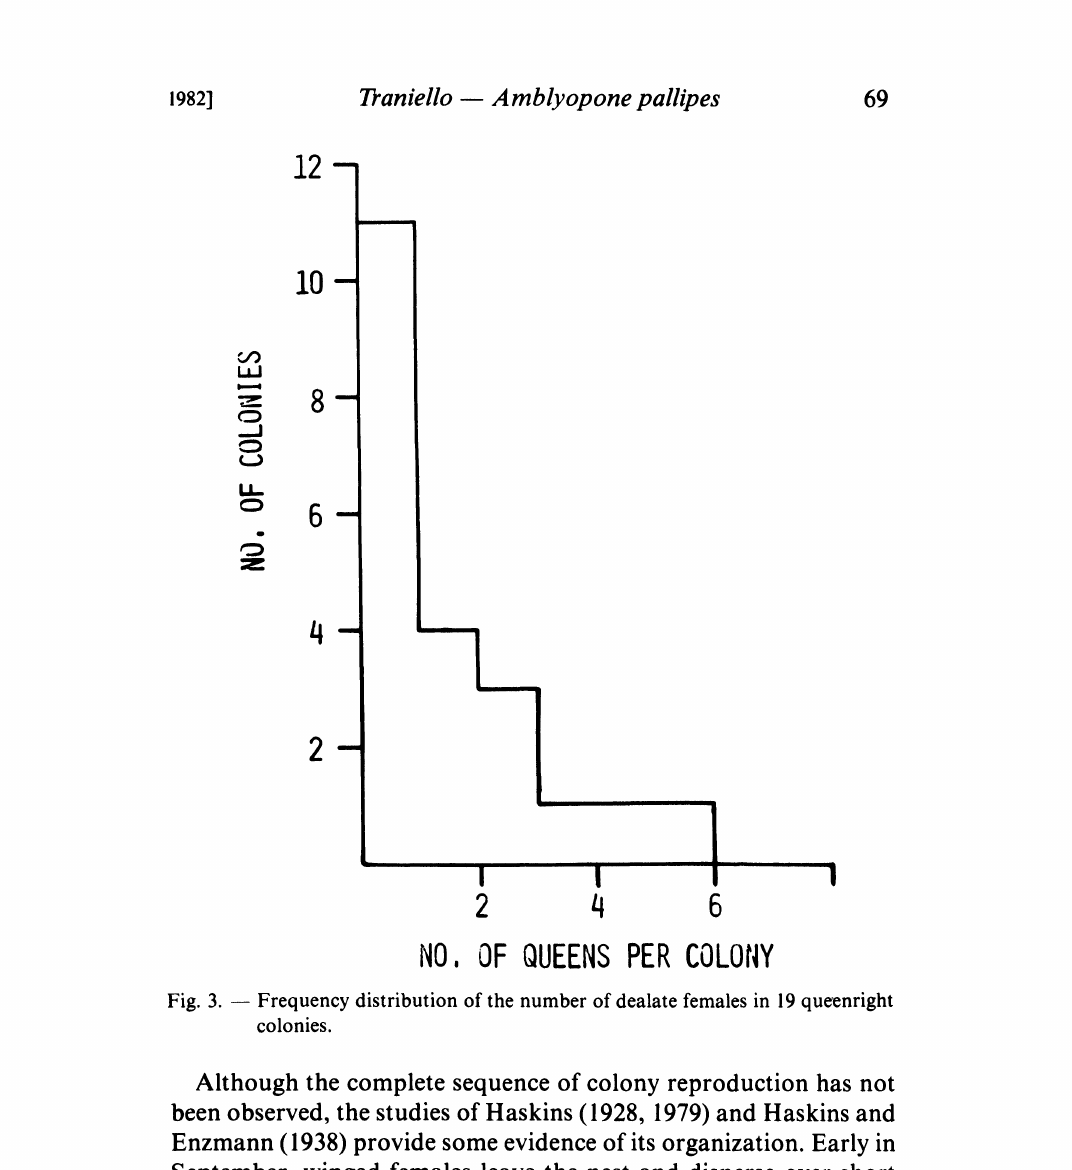
Fig. 3. Frequency distribution of the number of dealate females in 19 queenright